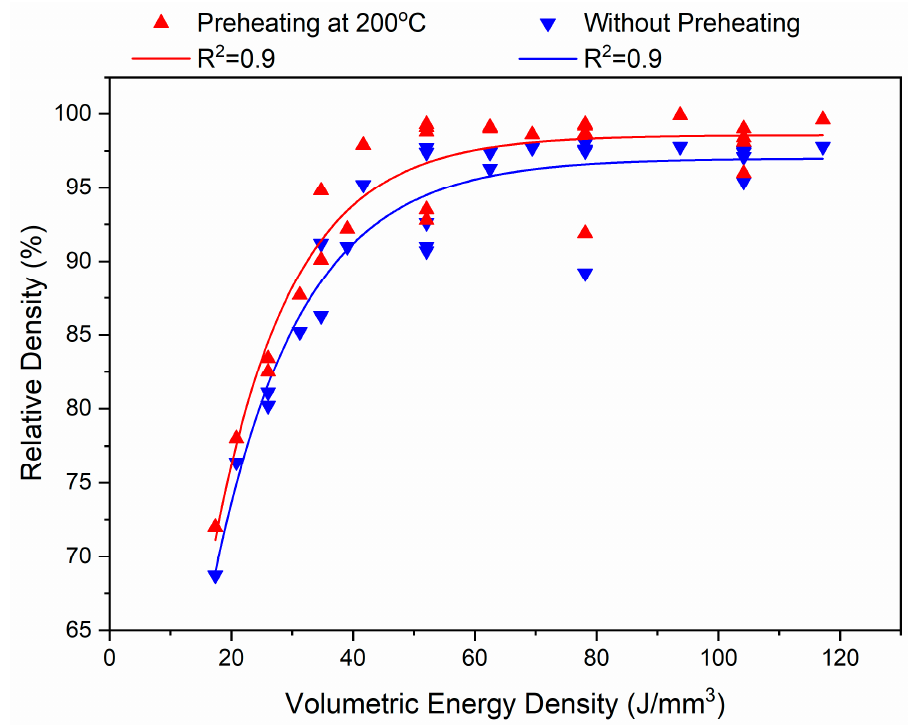
Figure 5. E ff ect of energy density on the relative density of the parts with and without Figure 5 . Effect of energy density on the relative density of the parts with and without preheating.